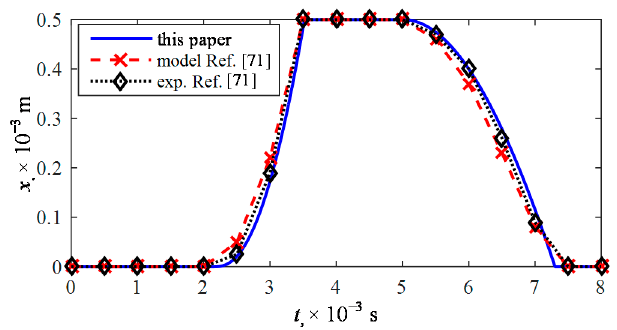
Figure 10. Calculation results verification.